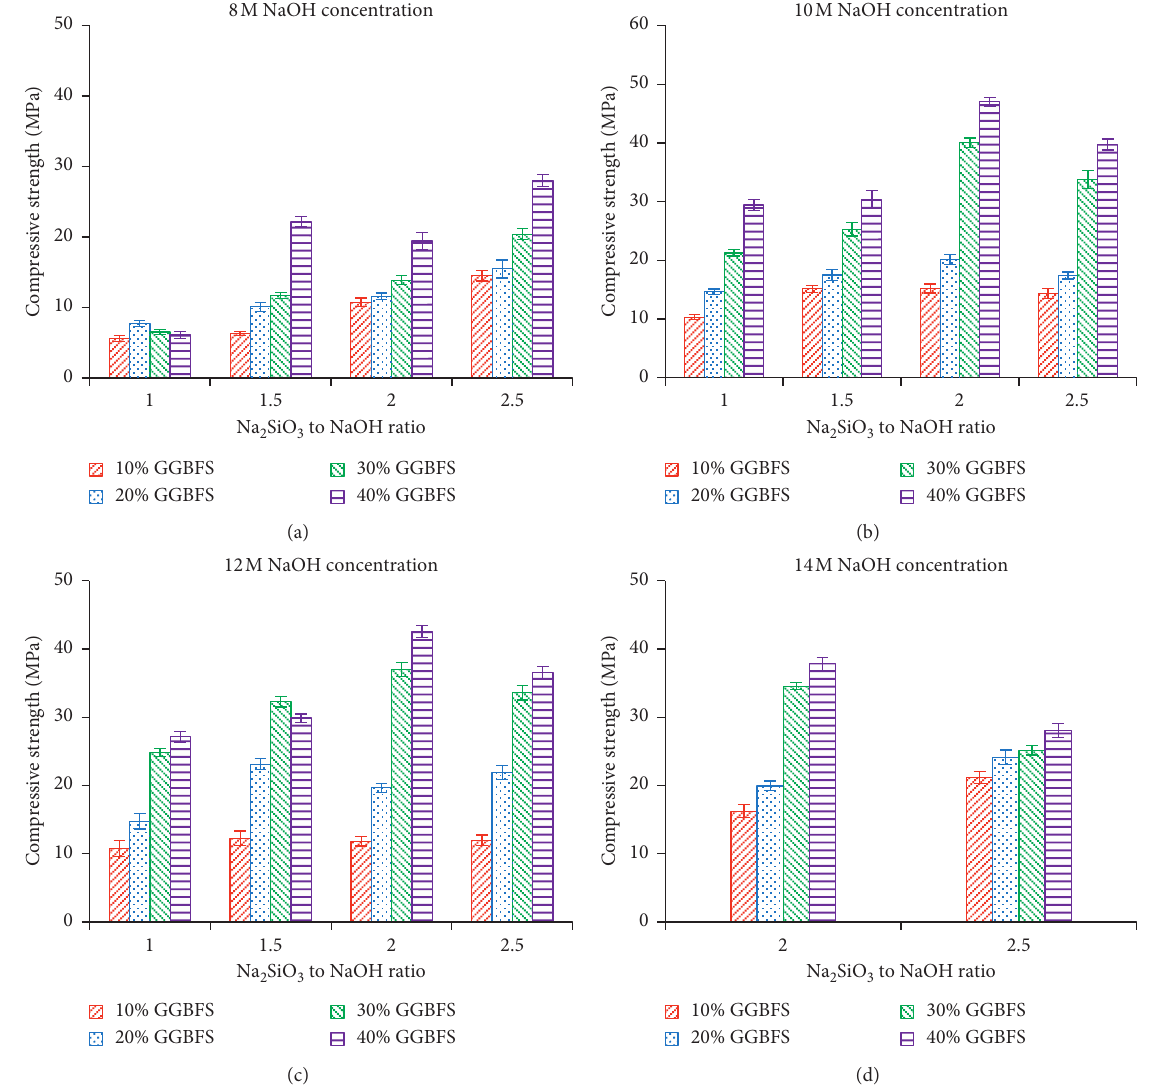
Figure 4: 28-day cylindrical compressive strength of fly ash-slag geopolymer